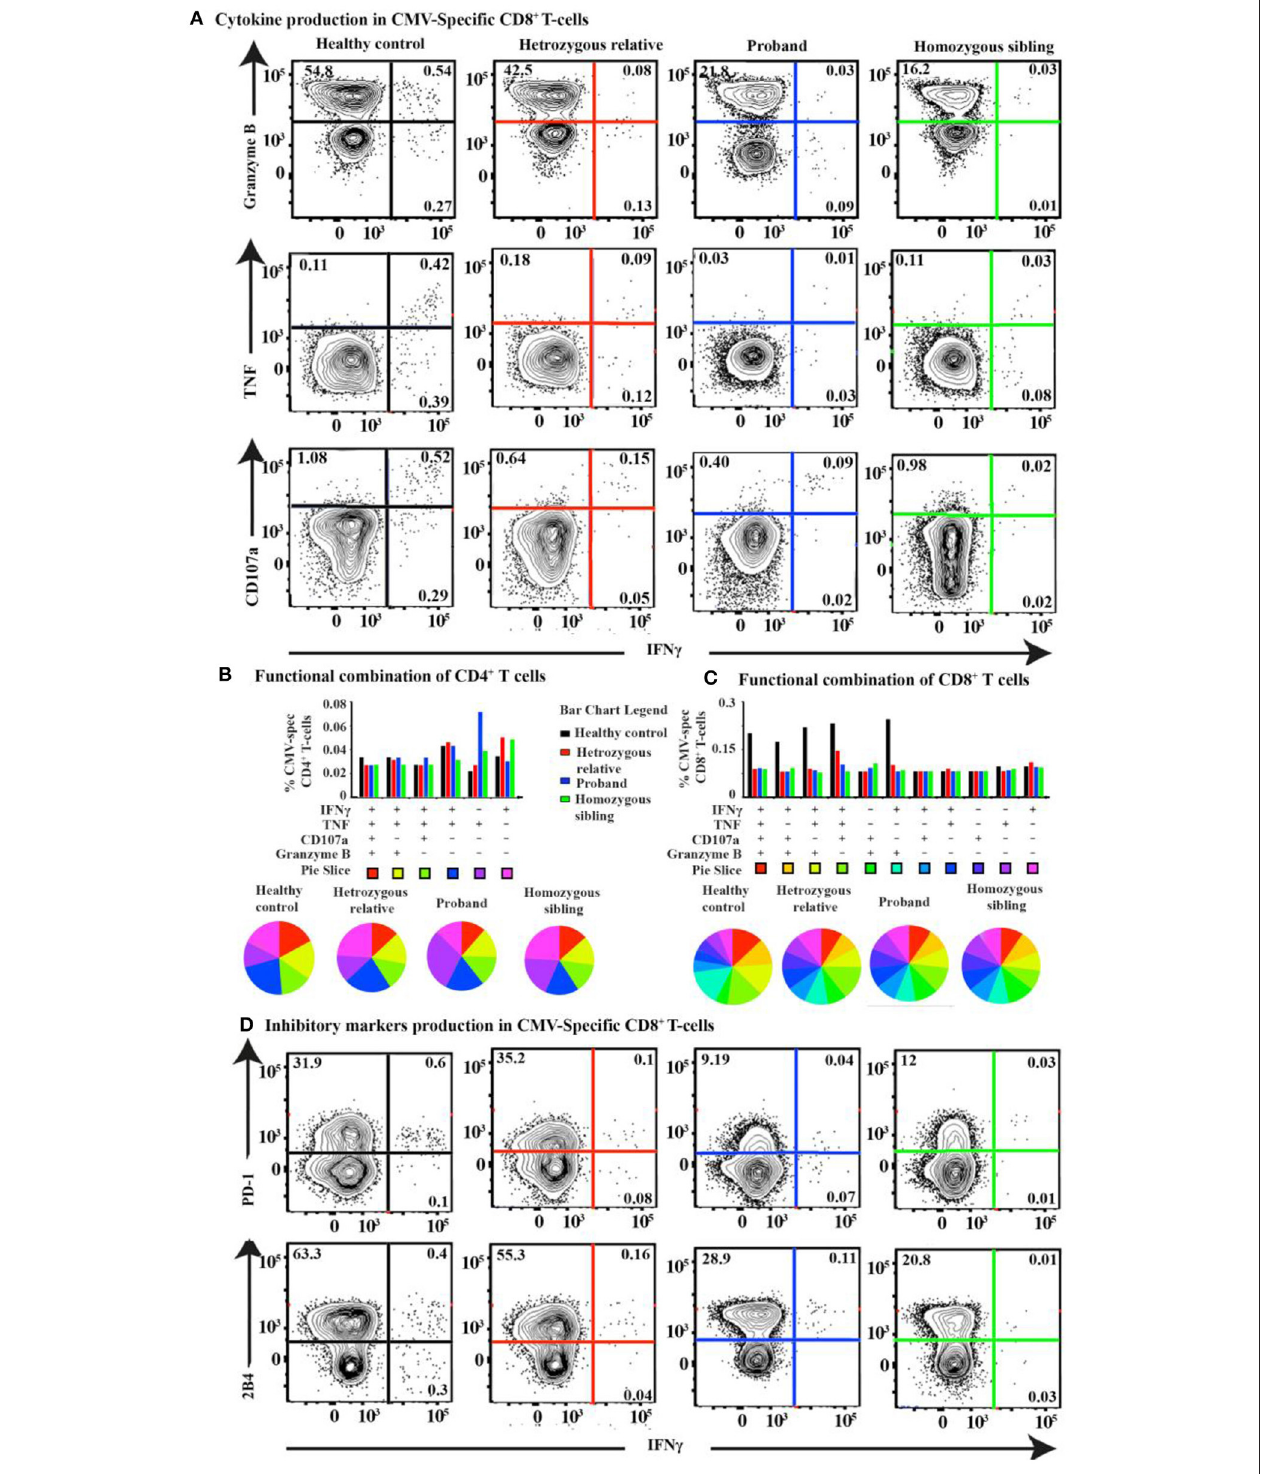
FIGURE 6 | T-cell response and cytokine production after CMV-pp65 antigen simulation in CD70 deficiency. (A) FACS plots of the IFN γ vs. granzyme B, TNF, and CD107a CMV-pp65-specific CD8 + T-cell response for the proband, the homozygous sibling, a heterozygous relative, and a healthy control. Corresponding SPICE analysis of all functional combinations (based on Boolean gating) for each patient’s CMV-specific (B) CD4 + and (C) CD8 + T-cell response. (D) FACS plots of the IFN γ vs. PD-1 and 2B4 CMV-pp65-specific CD8 + T-cell responses.